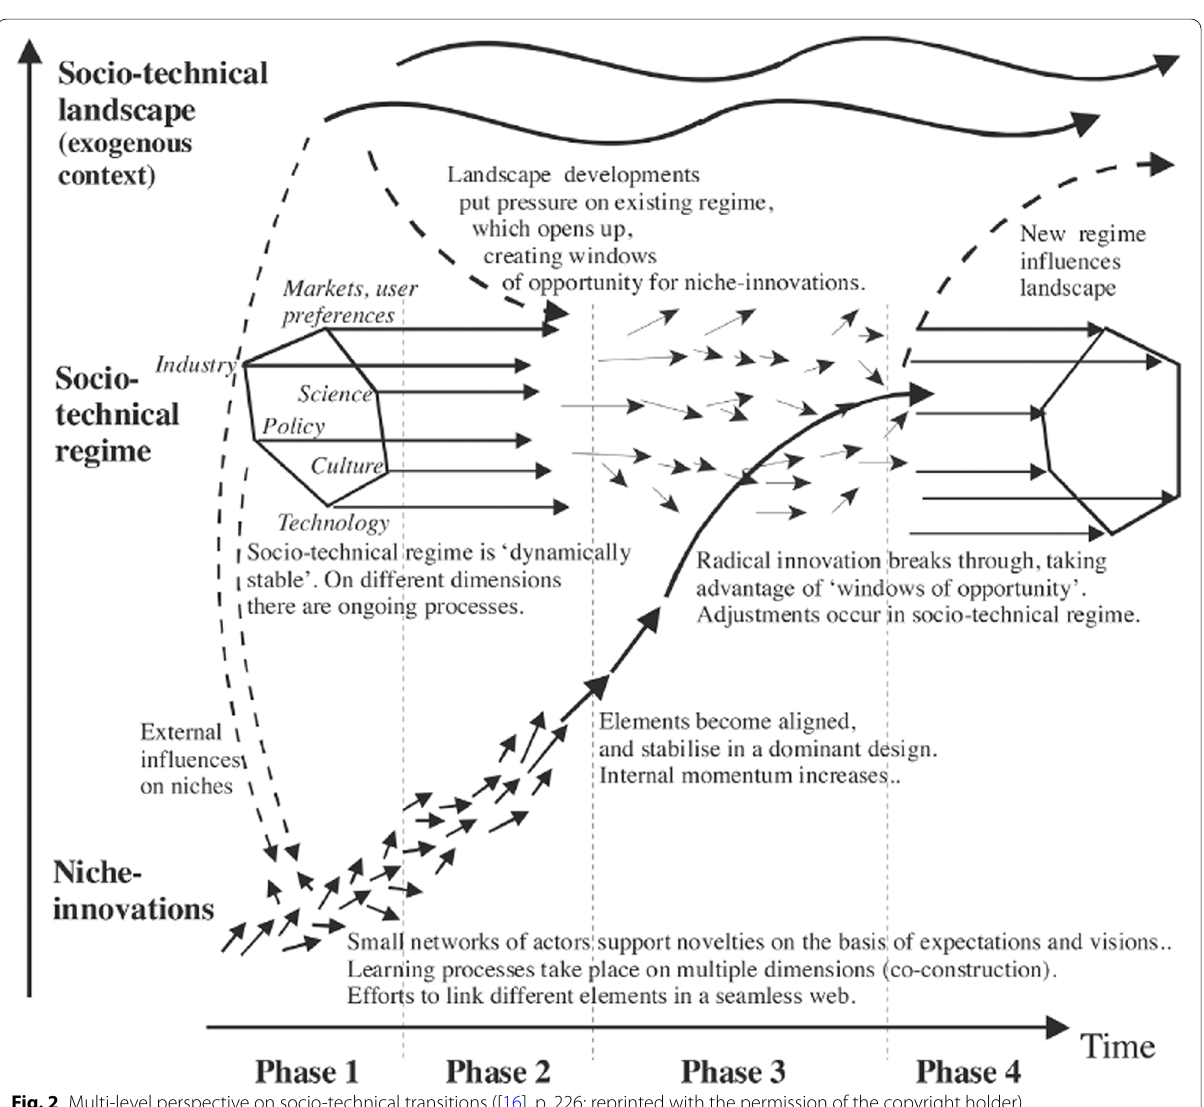
Fig. 2 Multi-level perspective on socio-technical transitions ([16], p. 226; reprinted with the permission of the copyright